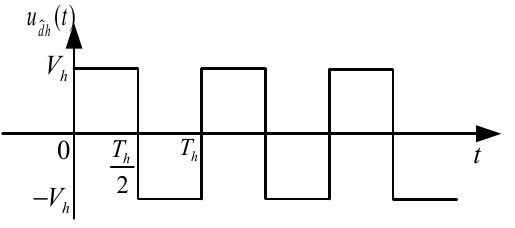
Figure 2. High-frequency square-wave voltage signal diagram.